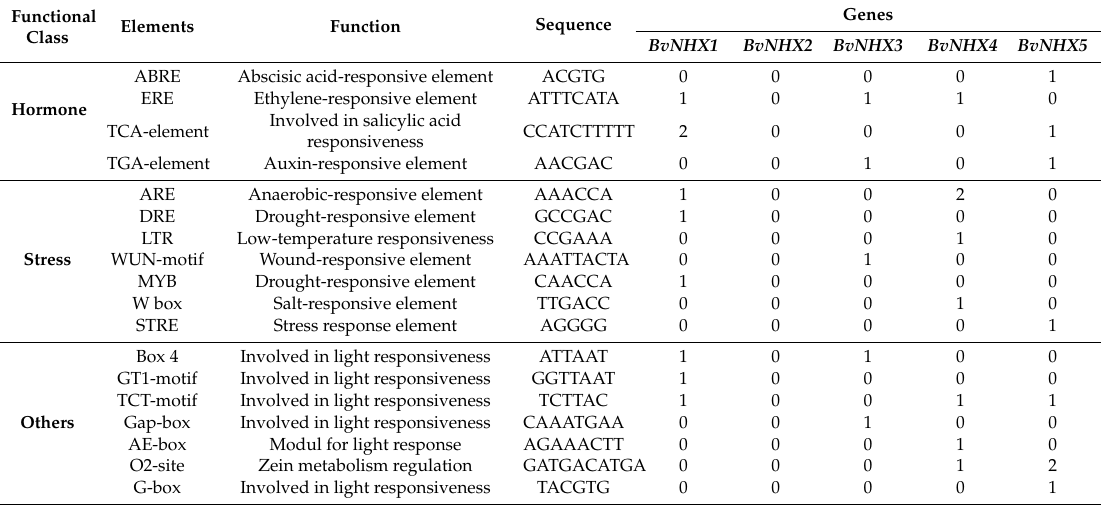
Table 5. Kinds and amounts of hormone-, stress-, and development-related cis -acting element in the promoters of BvNHX predicted by the PlantCARE